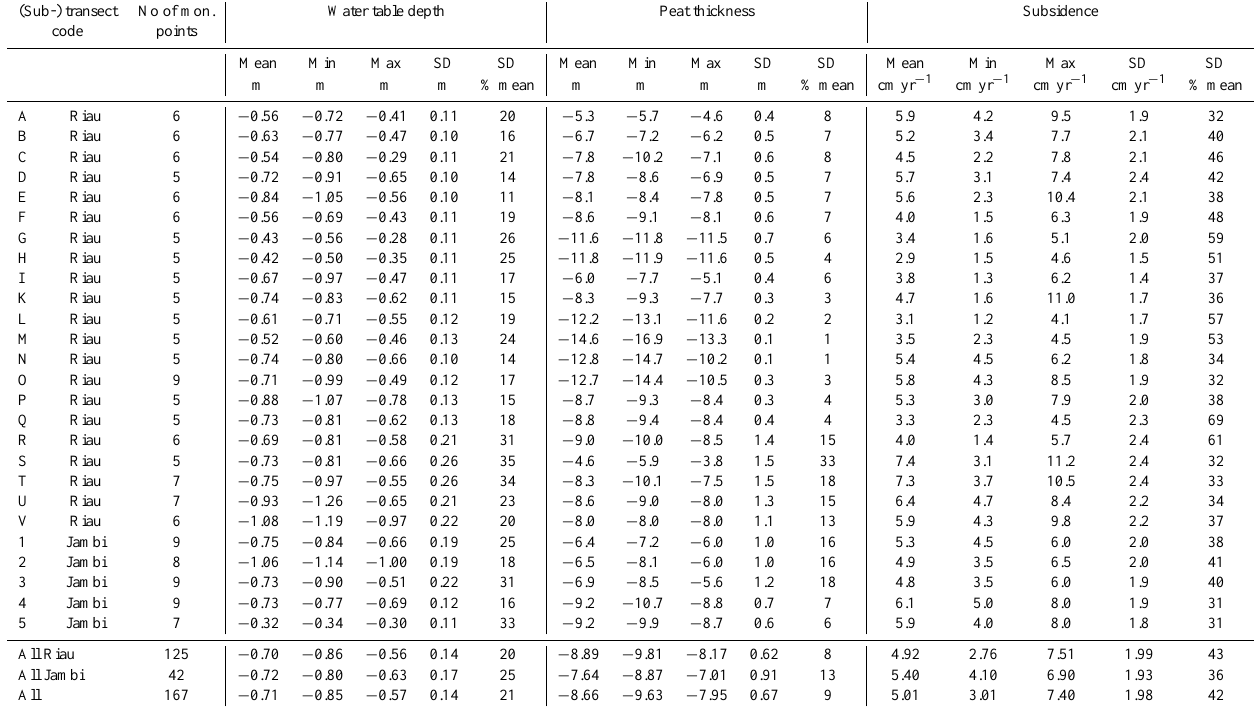
Table 3. Summary statistics of water depth, peat thickness and subsidence rate along all plantation transects, as calculated over groups of 5 to 9 adjacent measurement locations each. Mean, maximum and minimum values are calculated from average values for individual locations. The “Riau” locations are in Acacia plantation, the “Jambi” locations in oil palm. (Sub-) transect No of